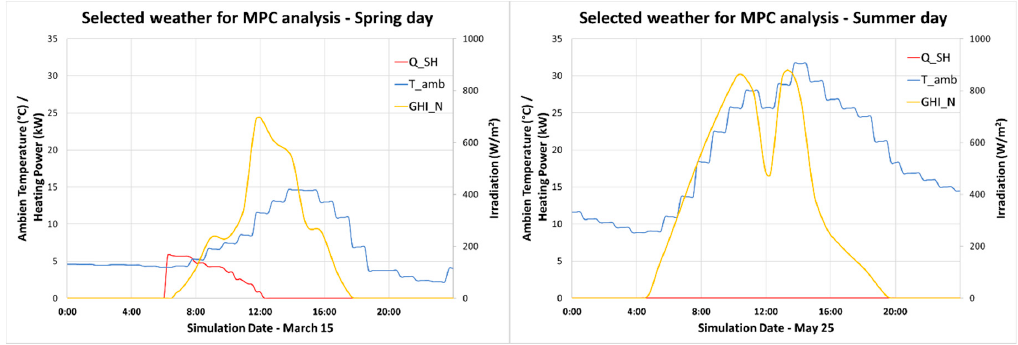
Figure 7. Selected spring day (left) and summer day (right) for the MPC analysis.